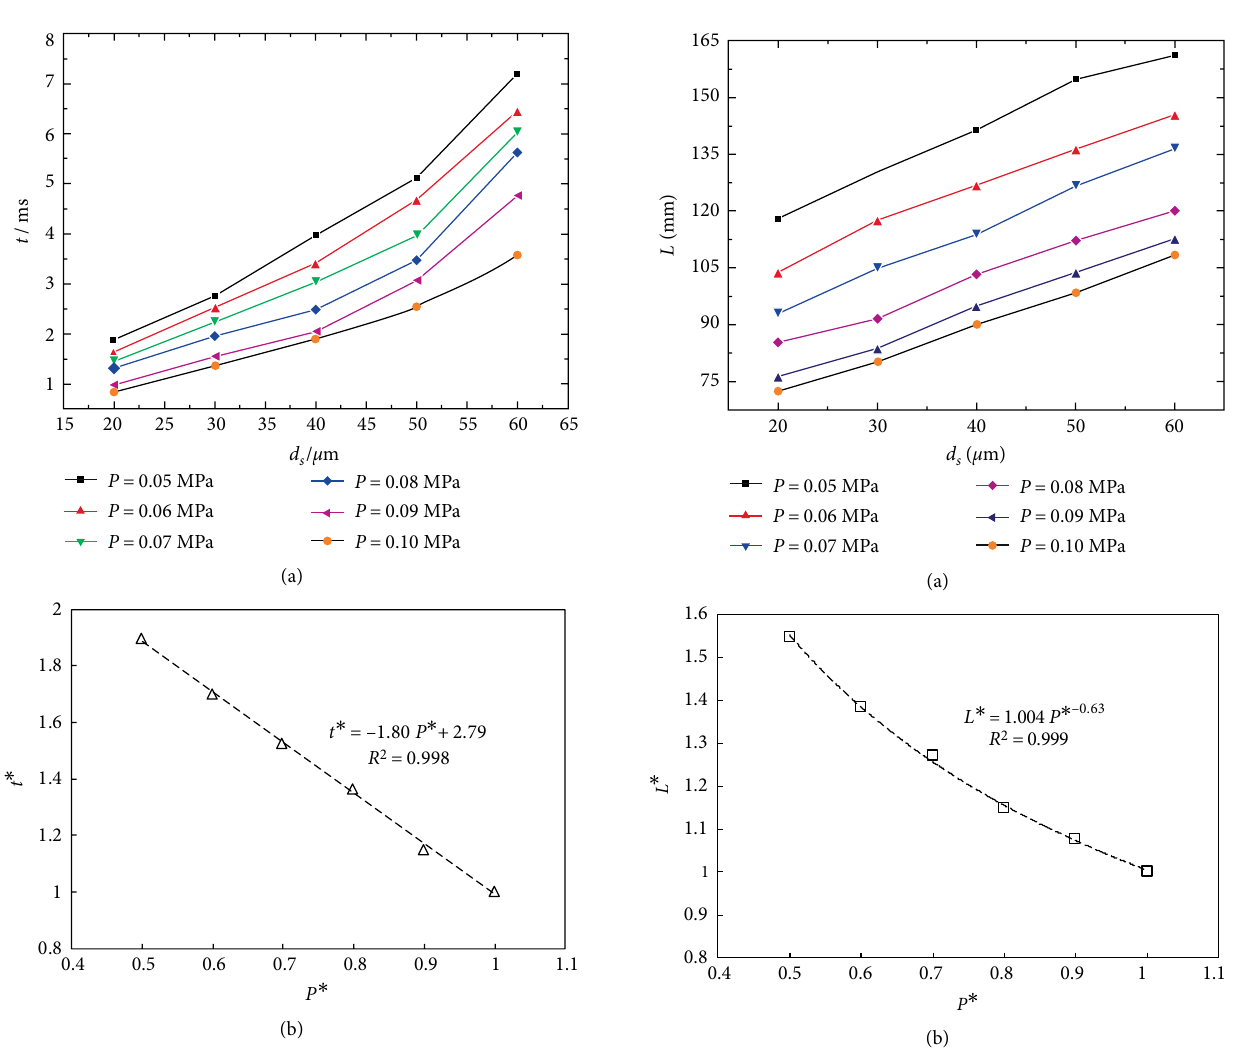
Figure 10: The burning path of the droplets: (a) droplets of different sizes under different atmospheric pressures, (b) the relationship between the average dimensionless burning path of all droplet sizes and atmospheric